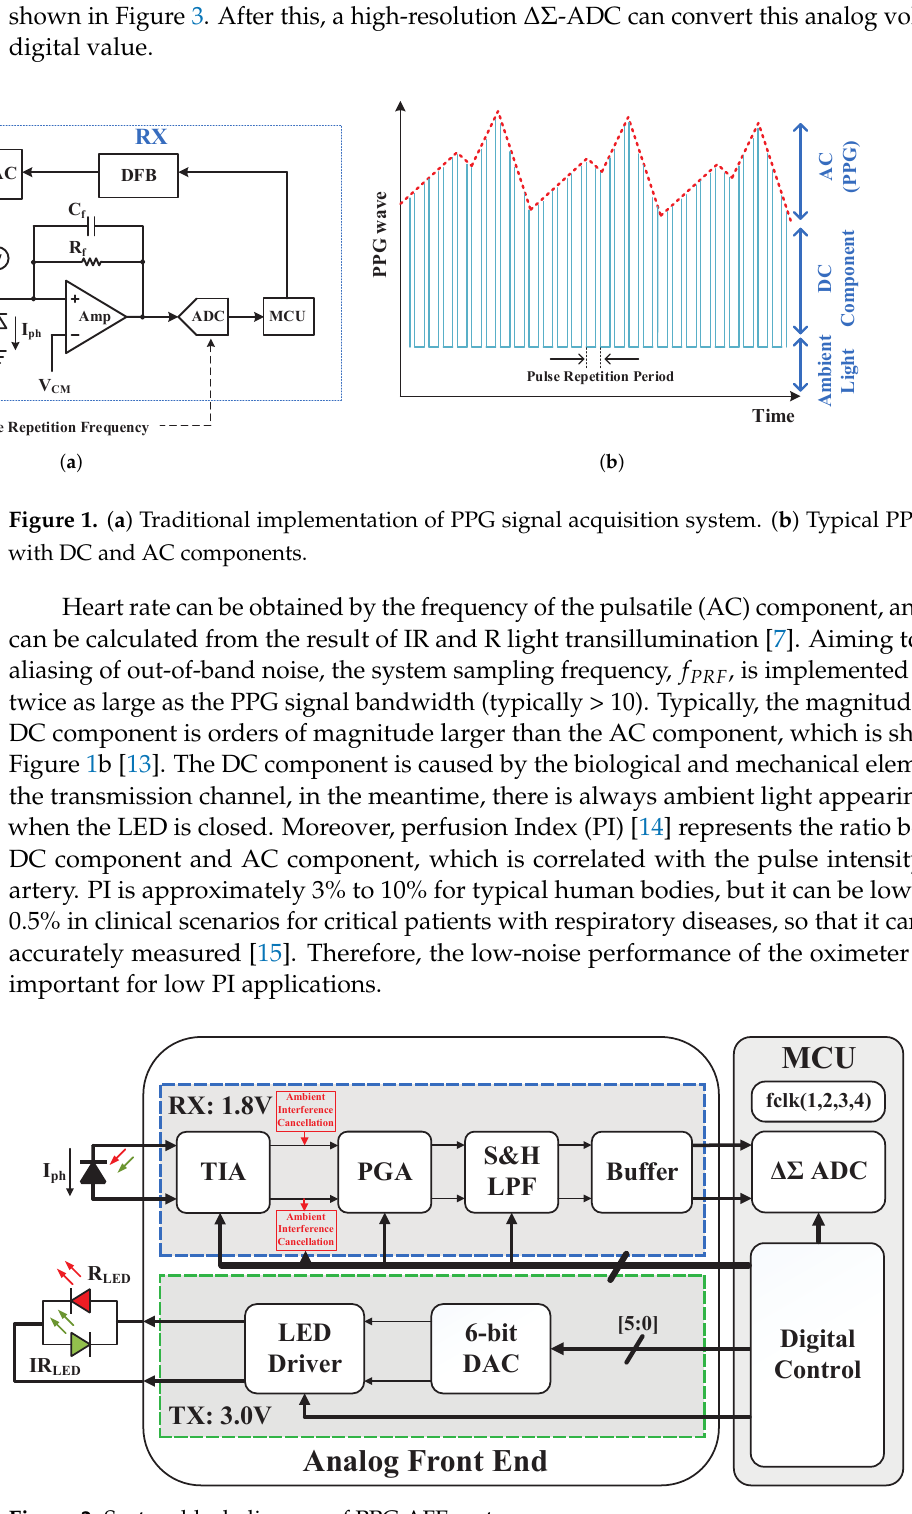
Figure 2. System block diagram of PPG AFE